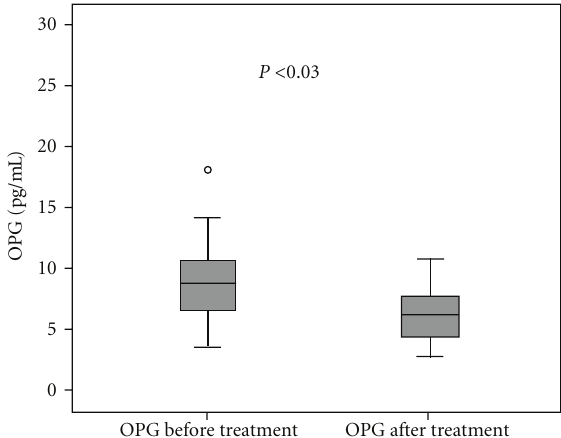
Figure 2: Serum OPG concentrations before and after treatment.